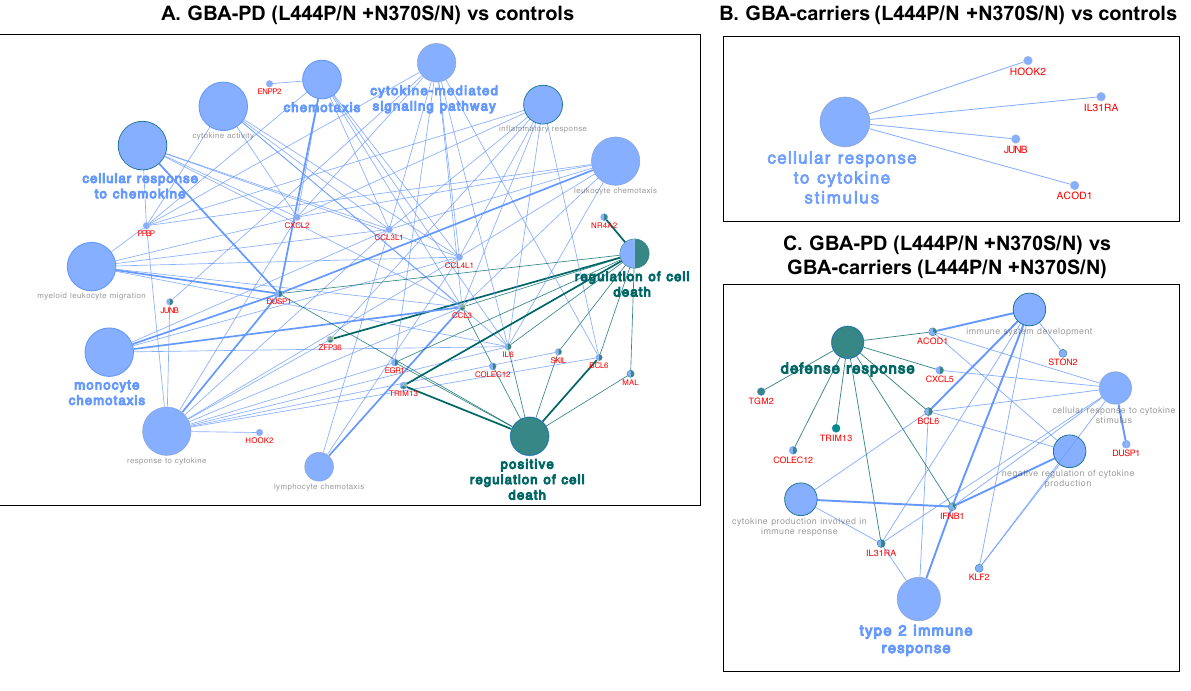
Figure 5. Networks of selected metabolic processes and DEGs in ( A ). GBA-PD (L444P/N +N370S/N) vs. controls; ( B ). GBA carriers (L444P/N +N370S/N) vs. controls; ( C ). GBA-PD (L444P/N +N370S/N) vs. GBA carriers (L444P/N +N370S/N) (obtained using CluePedia v. 1.5.7 + ClueGo v.2.5.7). (GBA-PD—Parkinson’s disease associated with mutations in the GBA gene; GBA carriers—asymptomatic GBA mutation carriers; DEGs—differentially expressed